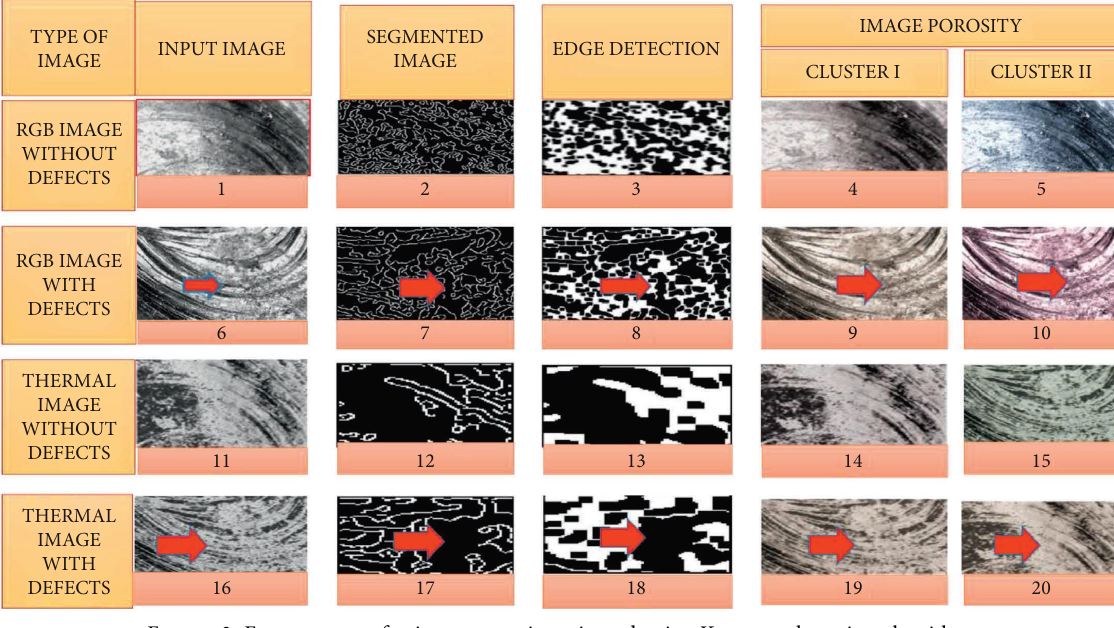
Figure 3: Fuzzy outputs for image porosity using adaptive K -means clustering algorithm.